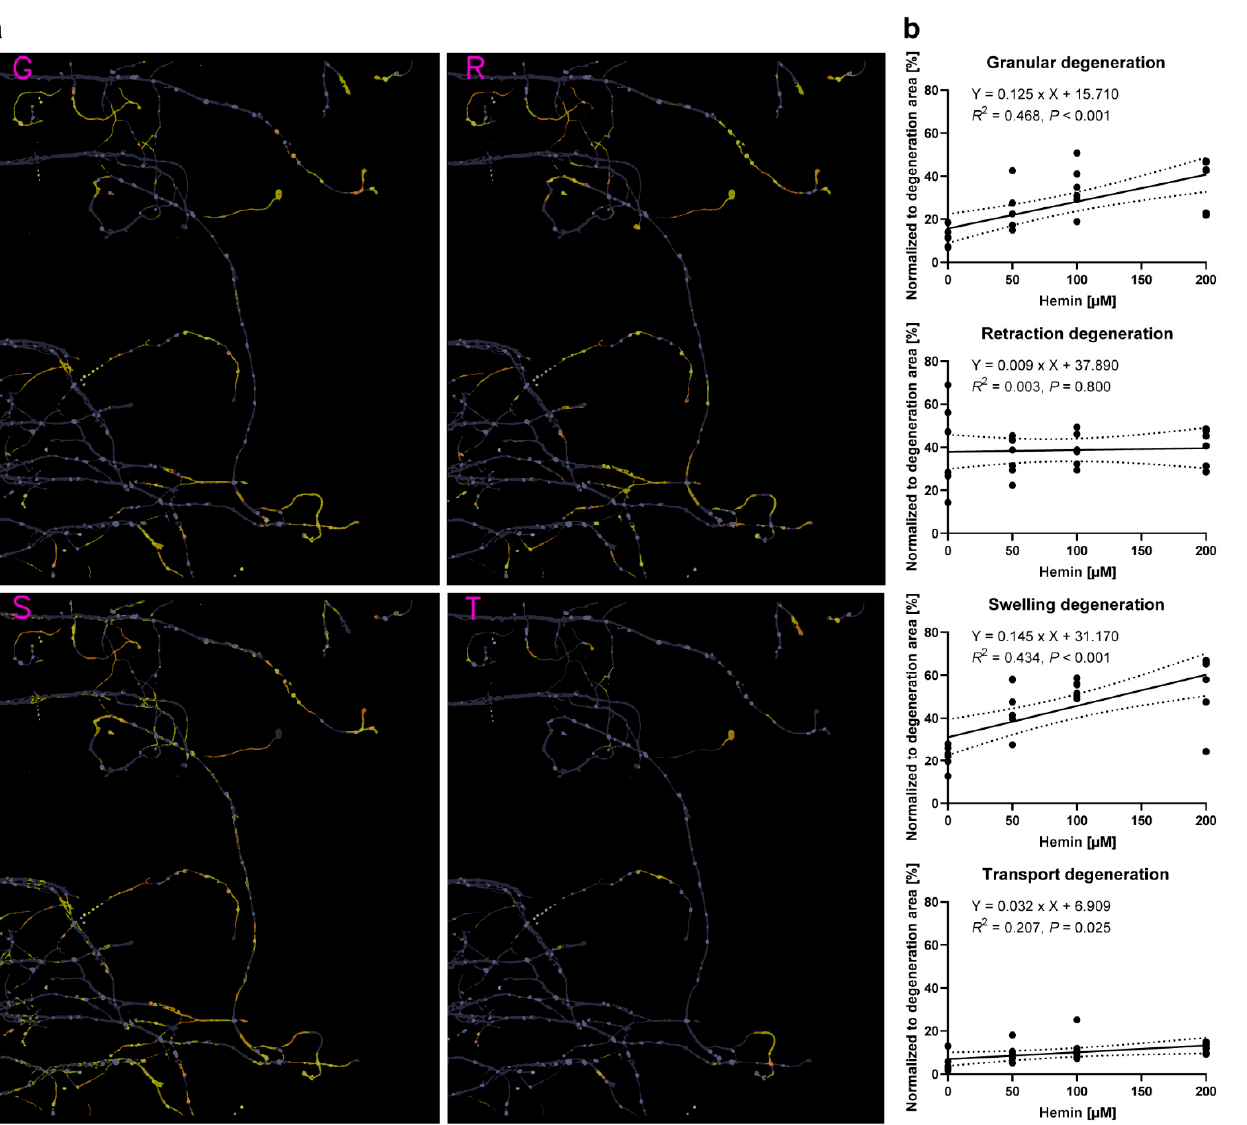
Figure 7. Concentration-dependent differences in the morphological patterns of hemin-induced AxD. ( a ) The classification of granular (G), retraction (R), swelling (S), and transport degeneration (T) in primary cortical axons treated with 200 µM hemin. For the complete time-lapse video including segmentation, refer to Video S9. ( b ) Linear regressions of the four morphological patterns of AxD in hemin-induced AxD. The area classified for each AxD pattern was normalized to the total degeneration area. Dotted lines show 95% confidence bands. N = 6 independent cultures of primary cortical neurons. Granular degeneration: F(1, 22) = 19.330, P < 0.001. Retraction degeneration: F(1, 22) = 0.066, P = 0.800. Swelling degeneration: F(1, 22) = 16.900, P < 0.001. Transport degeneration: F(1, 22) = 5.757, P = 0.025. When comparing the slopes of the different AxD patterns, granular and swelling degeneration were significantly different from transport and retraction degeneration ( P = 0.034 for granular vs. retraction degeneration, P = 0.026 for granular vs. transport degeneration, P = 0.030 for swelling vs. retraction degeneration, P = 0.026 for swelling vs. transport degeneration). For detailed statistical analysis, refer to Table S5.